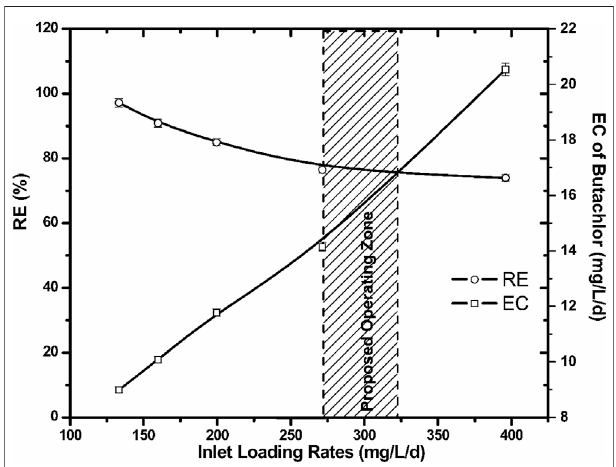
FIGURE 4 | In fl uence of inlet butachlor loading on the removal ef fi ciency and elimination capacity of the PBBR.